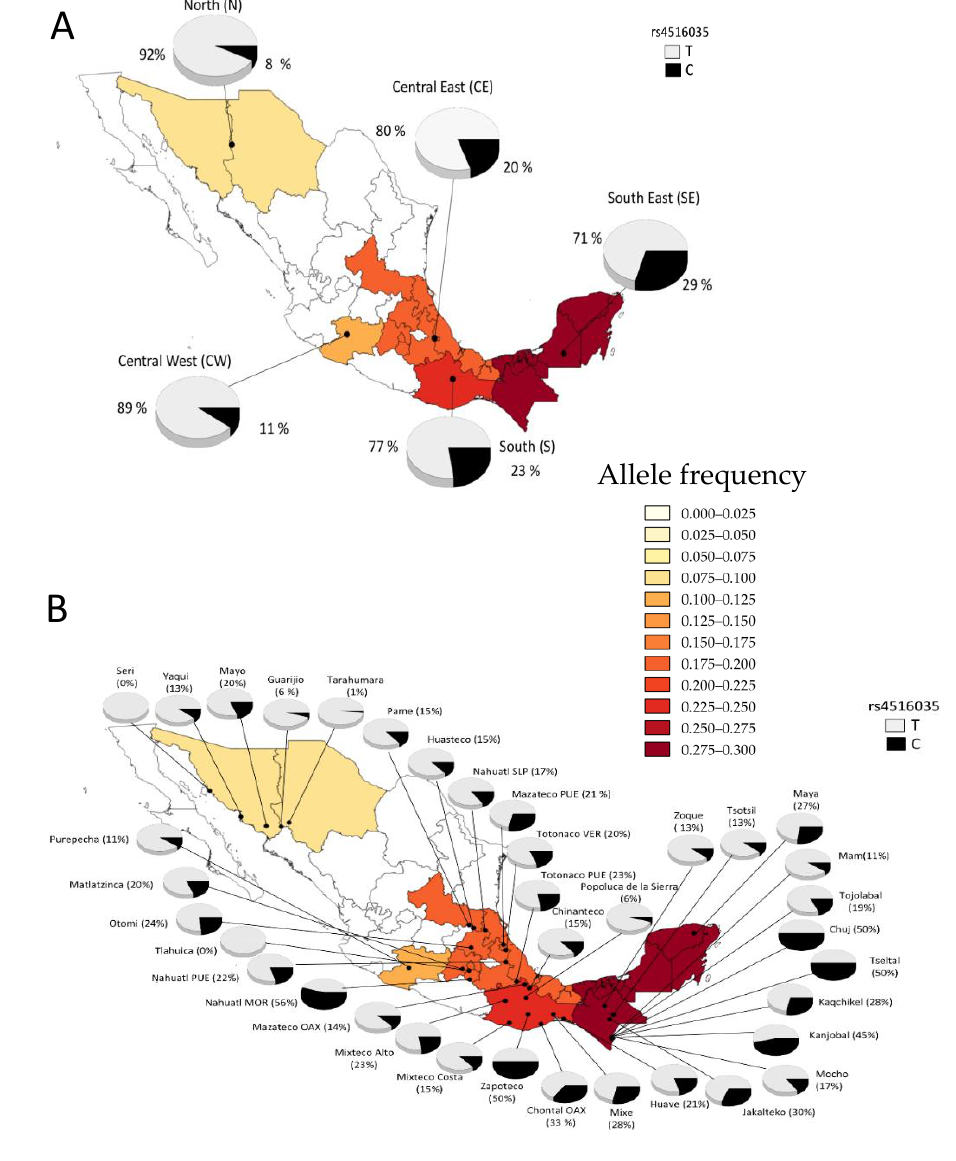
Figure 2. Geographic distribution of the allelic frequencies (T/C) for the rs4516035 polymorphism in Mexican Amerindian groups. MEX, Mexico State; MOR, Morelos; OAX, Oaxaca; PUE, Puebla; SLP, San Luis Potosi, VER, Veracruz. ( A ) Distribution of the allelic frequencies for the rs4516035 polymorphism within each geographic region. ( B ) Allelic frequencies for the rs4516035 polymorphism in the Amerindian groups.